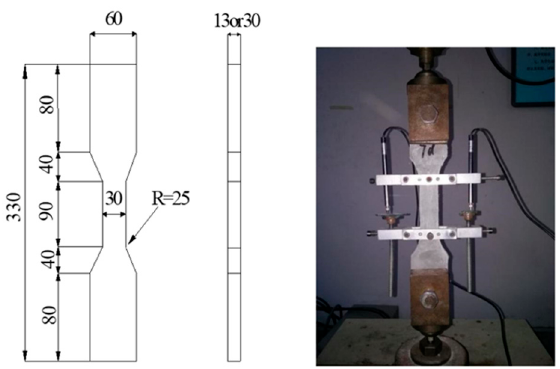
Figure 4. Dog-bone-shaped specimen for uniaxial tensile test (all dimensions in mm).